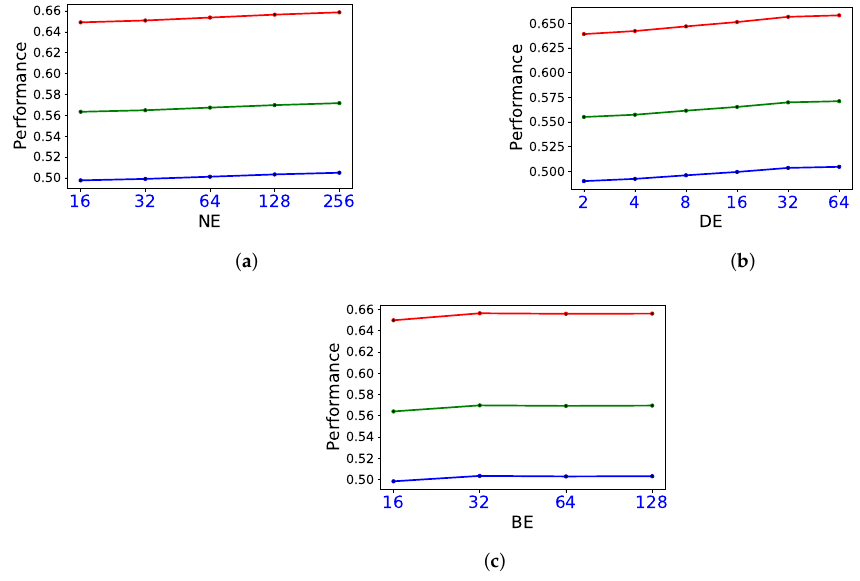
Figure 5. Sensitivity analysis on different parameter settings, including dimension of node attribute ( a ), dimension of edge embedding ( b ) and dimension of base embedding ( c ), where the red polyline represents Top-1 precision, the green polyline represents Top-1 F1 and the blue polyline represents Top-1